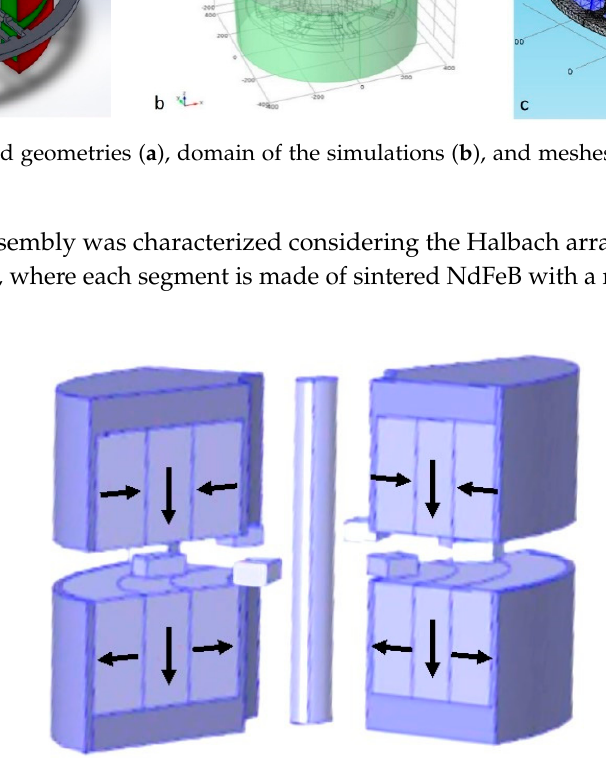
Figure 4. Configuration of the permanent magnets as Halbach array.